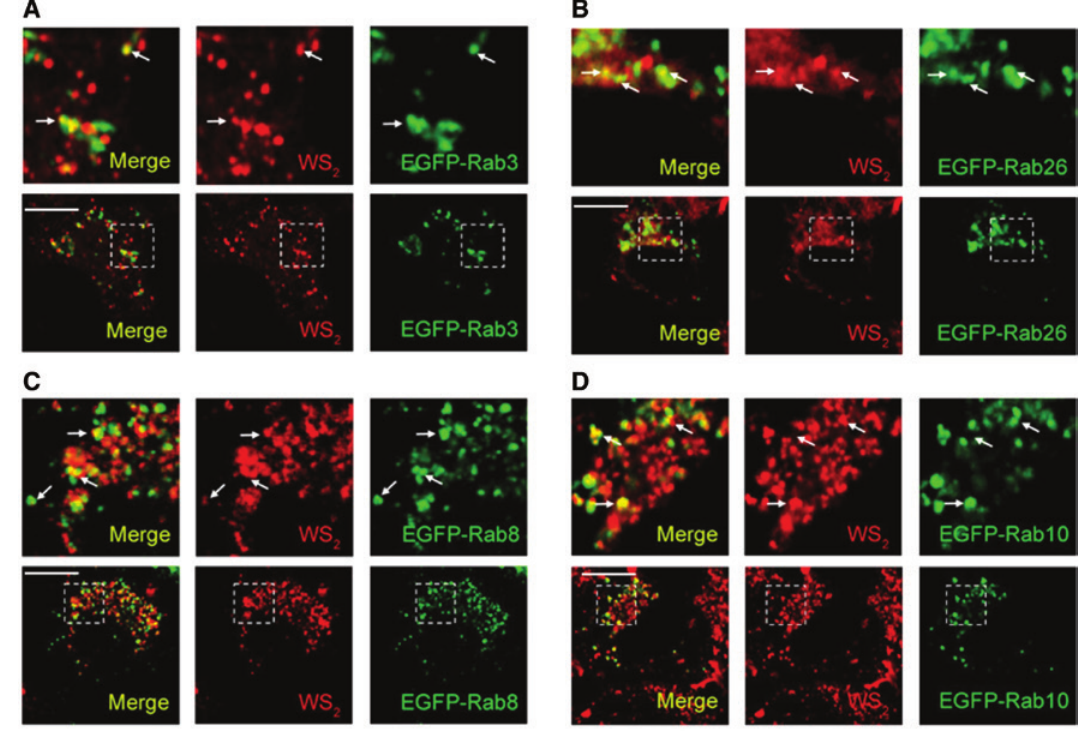
Figure 6: Exocytosis-mediated secretion of WS2 NSs. (A) HeLa cells were transfected with EGFP-Rab3 plasmid, and then the cells were incubated with WS2-PEG/RB NSs for 2 h. The co-localization was determined by CLSM. (B) HeLa cells were transfected with EGFP-Rab26 plasmid, and then the cells were incubated with WS2-PEG/RB NSs for 2 h. The co-localization was determined by CLSM. (C) HeLa cells were transfected with EGFP-Rab8 plasmid, and then the cells were incubated with WS -PEG/RB NSs for 2 h. The co-localization was determined by CLSM. (D) HeLa cells were transfected with 2